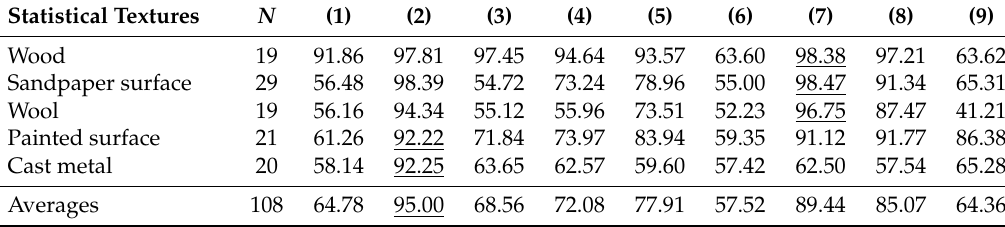
Table 4. Numerical values obtained using different thresholding methods on statistical textures: (1) the average method, (2) the minima of the maxima of the histogram (MiMa) method, (3) the Riddler method, (4) the Thrussel method, (5) the Otsu method, (6) the Pun method, (7) the Kapur method,(8)